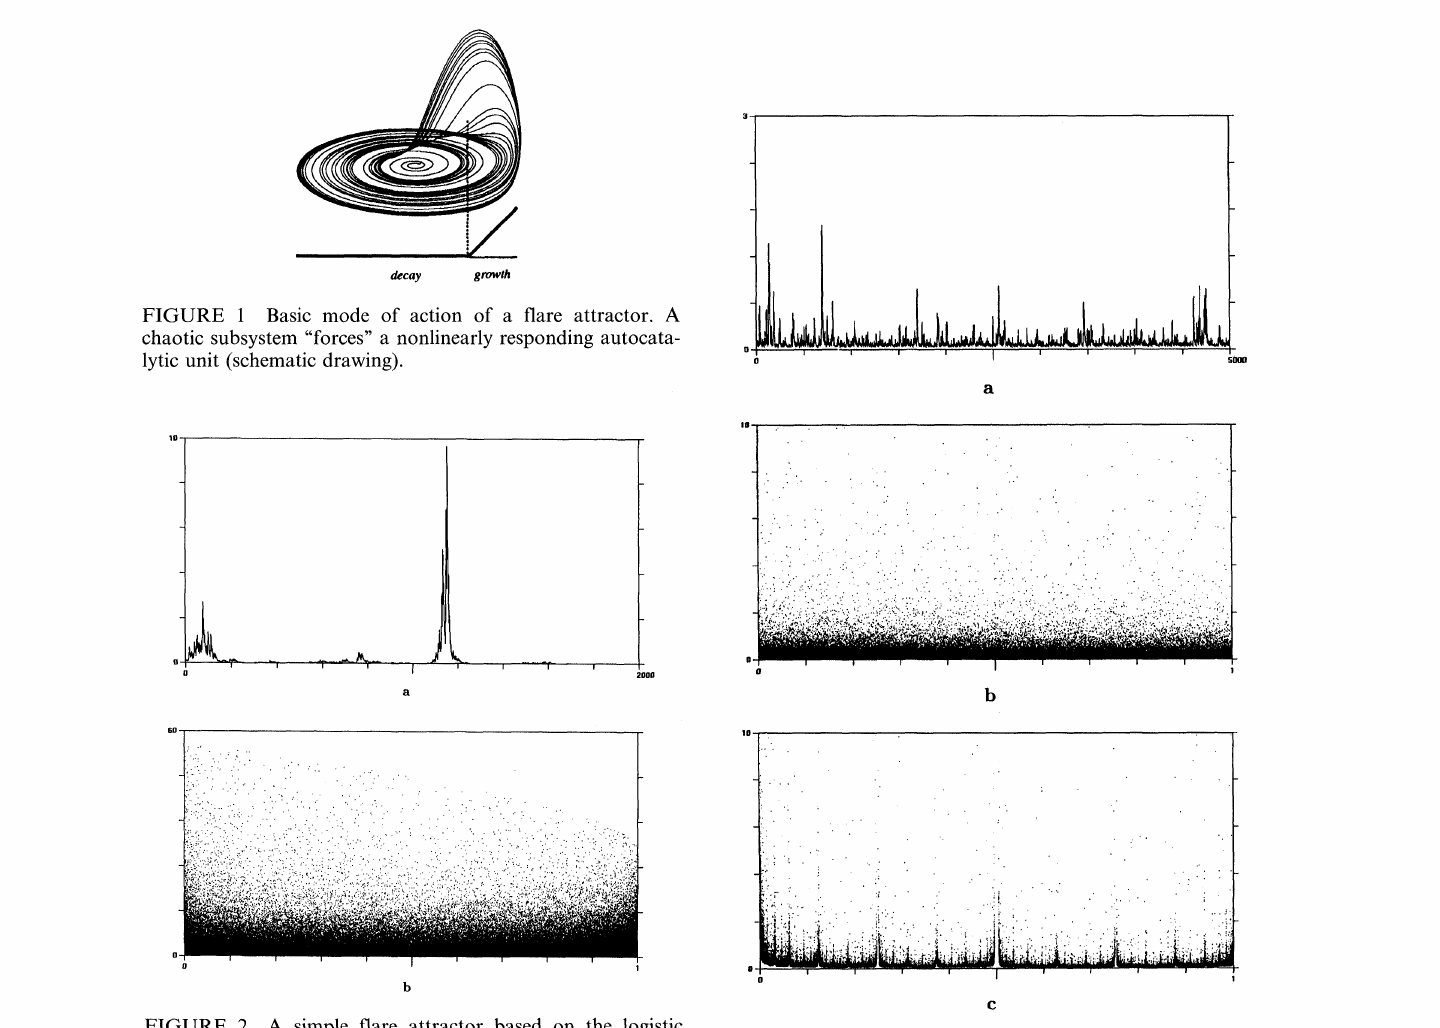
FIGURE 2 A simple flare attractor based on the logistic difference equation: Numerical simulation of Eq. (1). (a) Time plot of the flaring variable, b. Hereby successive points were connected by a straight line segment. (b) Side view (x, b plot). Parameter values: threshold=0.7, e=0.01. Initial conditions: x =0, b 1. Iteration number: 2000 for (a); and 1000000 for (b). This and all following calculations were done at 16- digit precision.